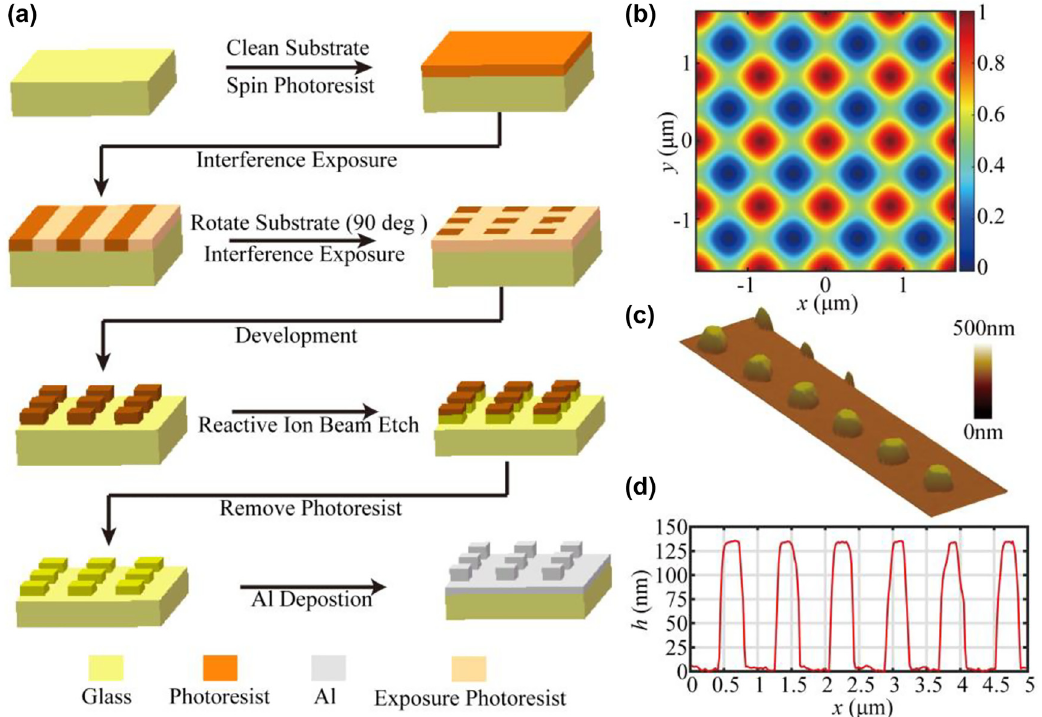
Figure 3: Fabrication of two-dimensional grating. (a) Process flow in two-dimensional grating fabrication; (b) normalized electrical intensity distribution in the superposition of field intensities for the two orthogonal interference exposures. (c) Atomic microscopy image and (d) cross-section graph of the photoresist mask.